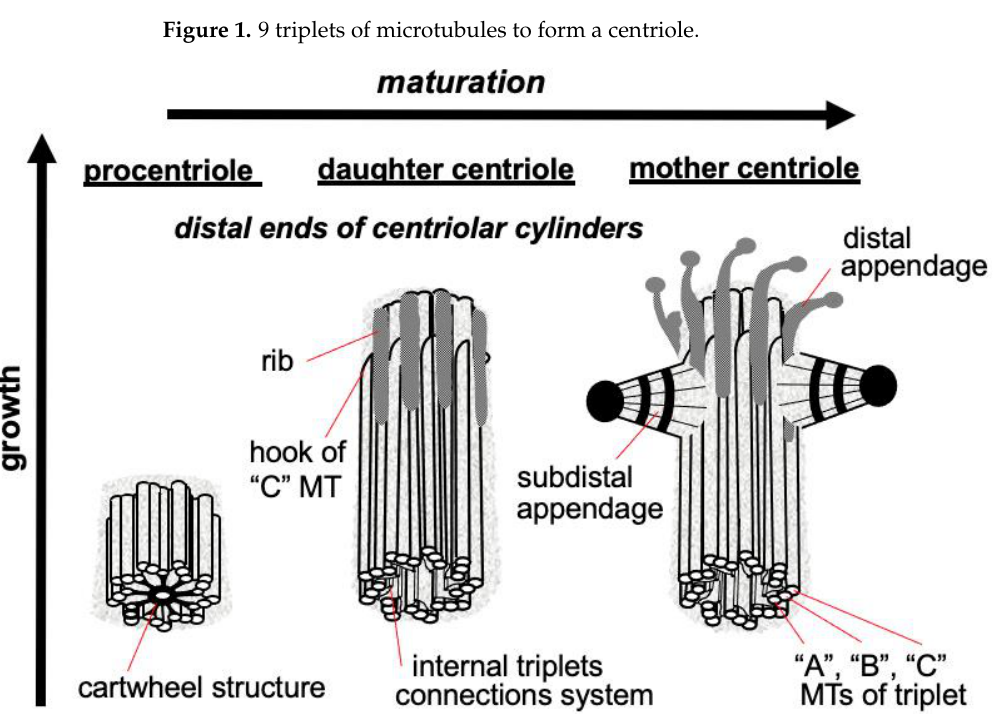
Figure 2. Procentriole, daughter and mother centrioles. Three morphological types of centriolar cylinders that can simultaneously exist in a cell. The mother centriole has an “age” at least 2 cell cycles, the daughter centriole originated in the previous cell cycle, the procentriole appeared in the current cell cycle.